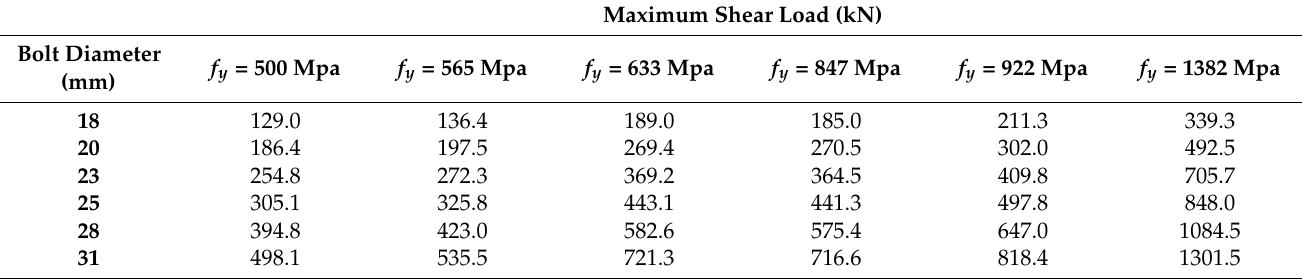
Table 11. Maximum static shear load of bolts.